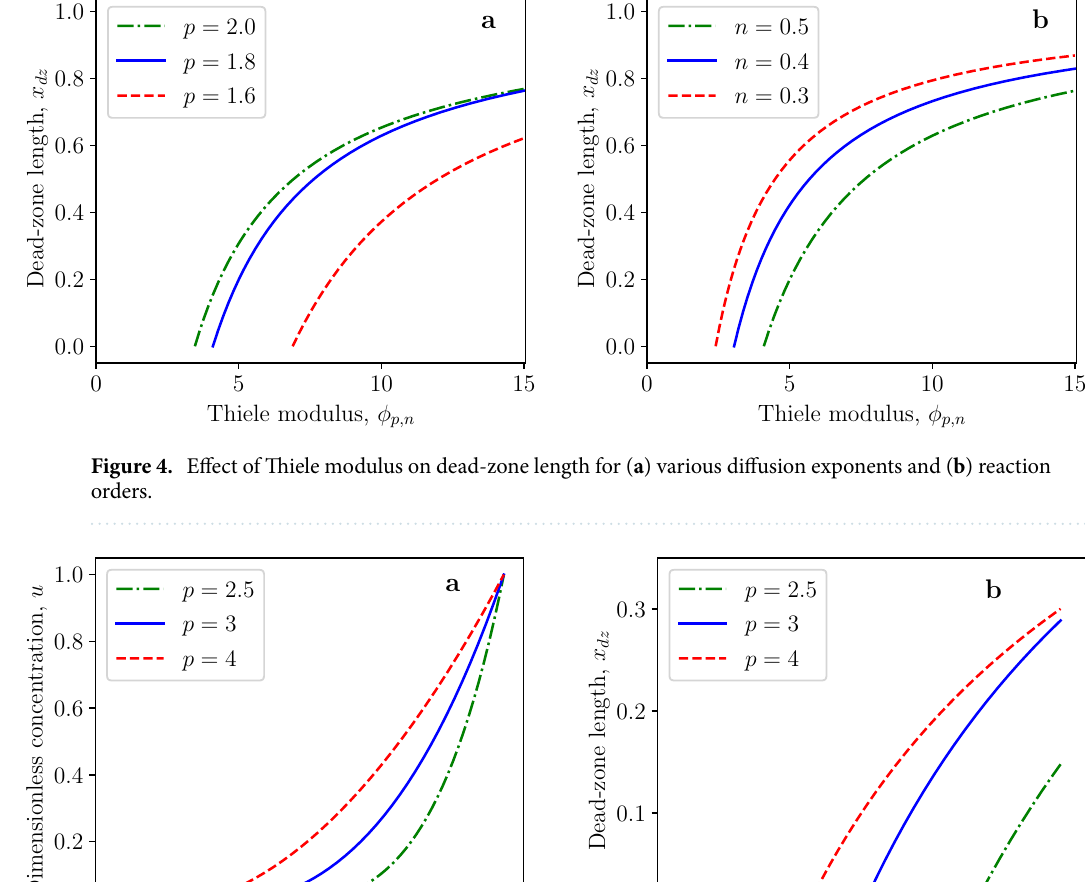
0 . 1.2 φ 1 ) and φ p , n = ∗ p , n . ( b ) Effect of = 1 ). =